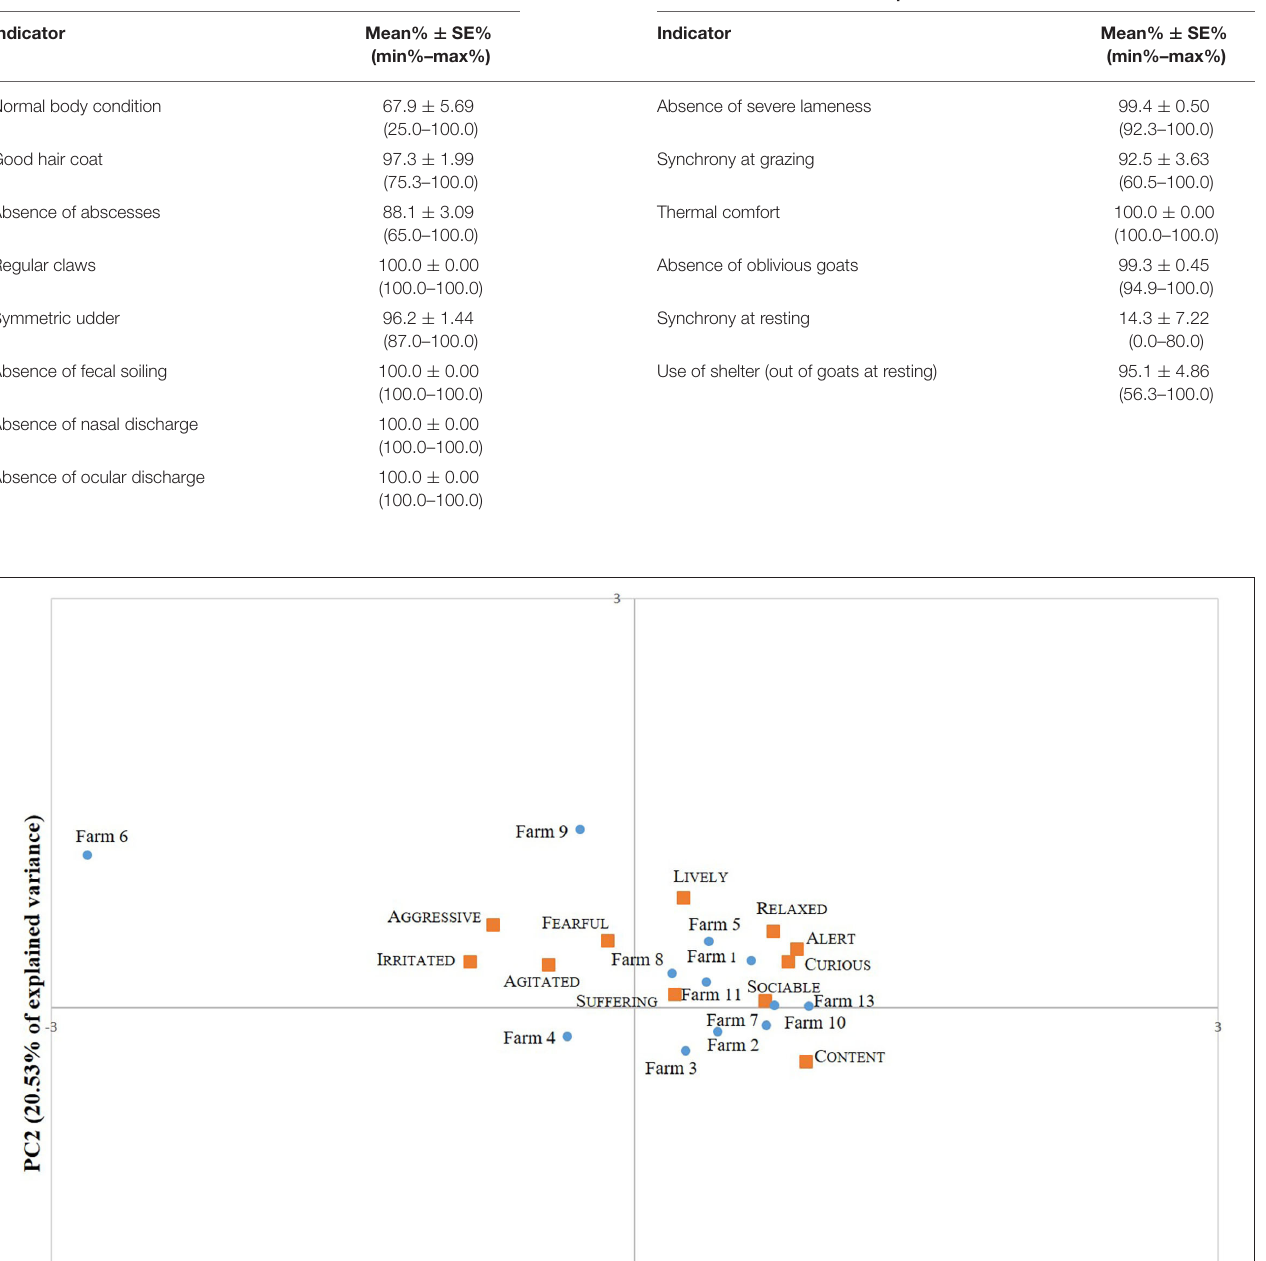
Frontiers in Veterinary Science |